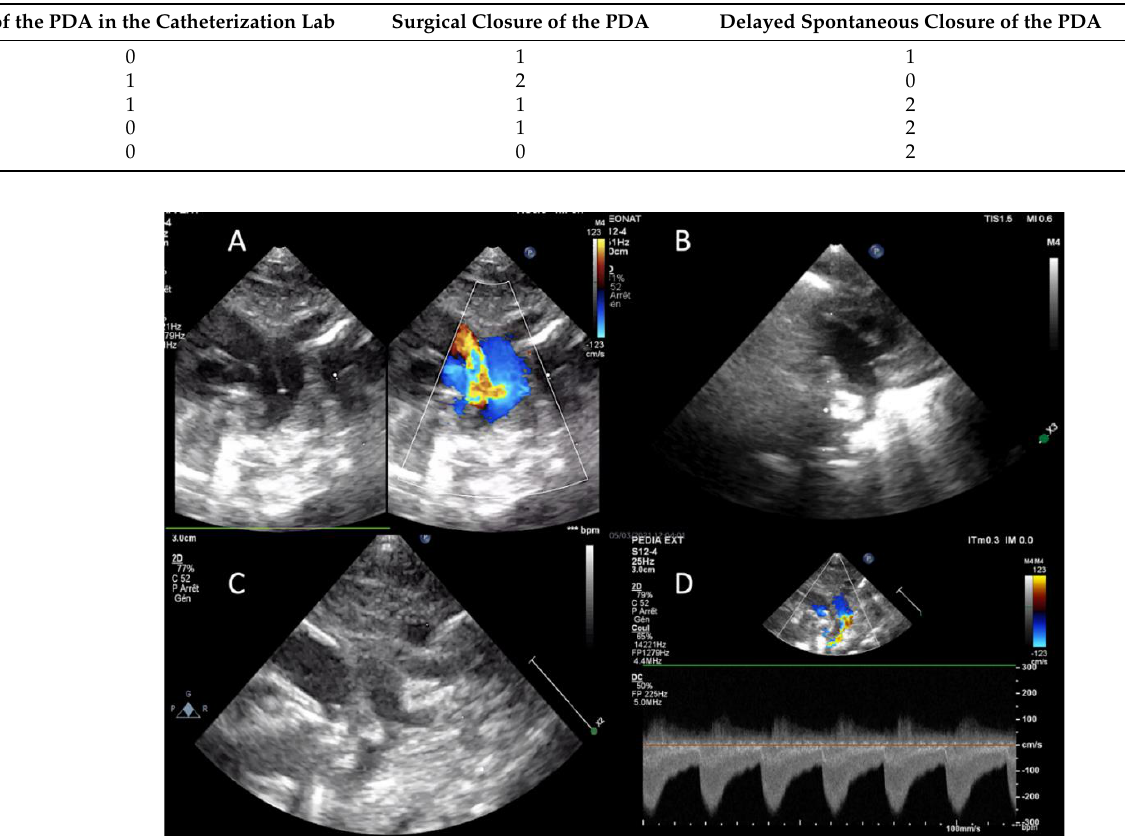
Figure 2. ( A ) PDA and aortic isthmus at the beginning of the procedure. Arrow is the F-type large PDA. ( B ) Protrusion of the device in the aorta occluding the isthmus. ( C ) Aortic isthmus and PDA spasm persisting after removal of the device. ( D ) Typical coarctation flow with diastolic run off on the isthmus after removal of the device.